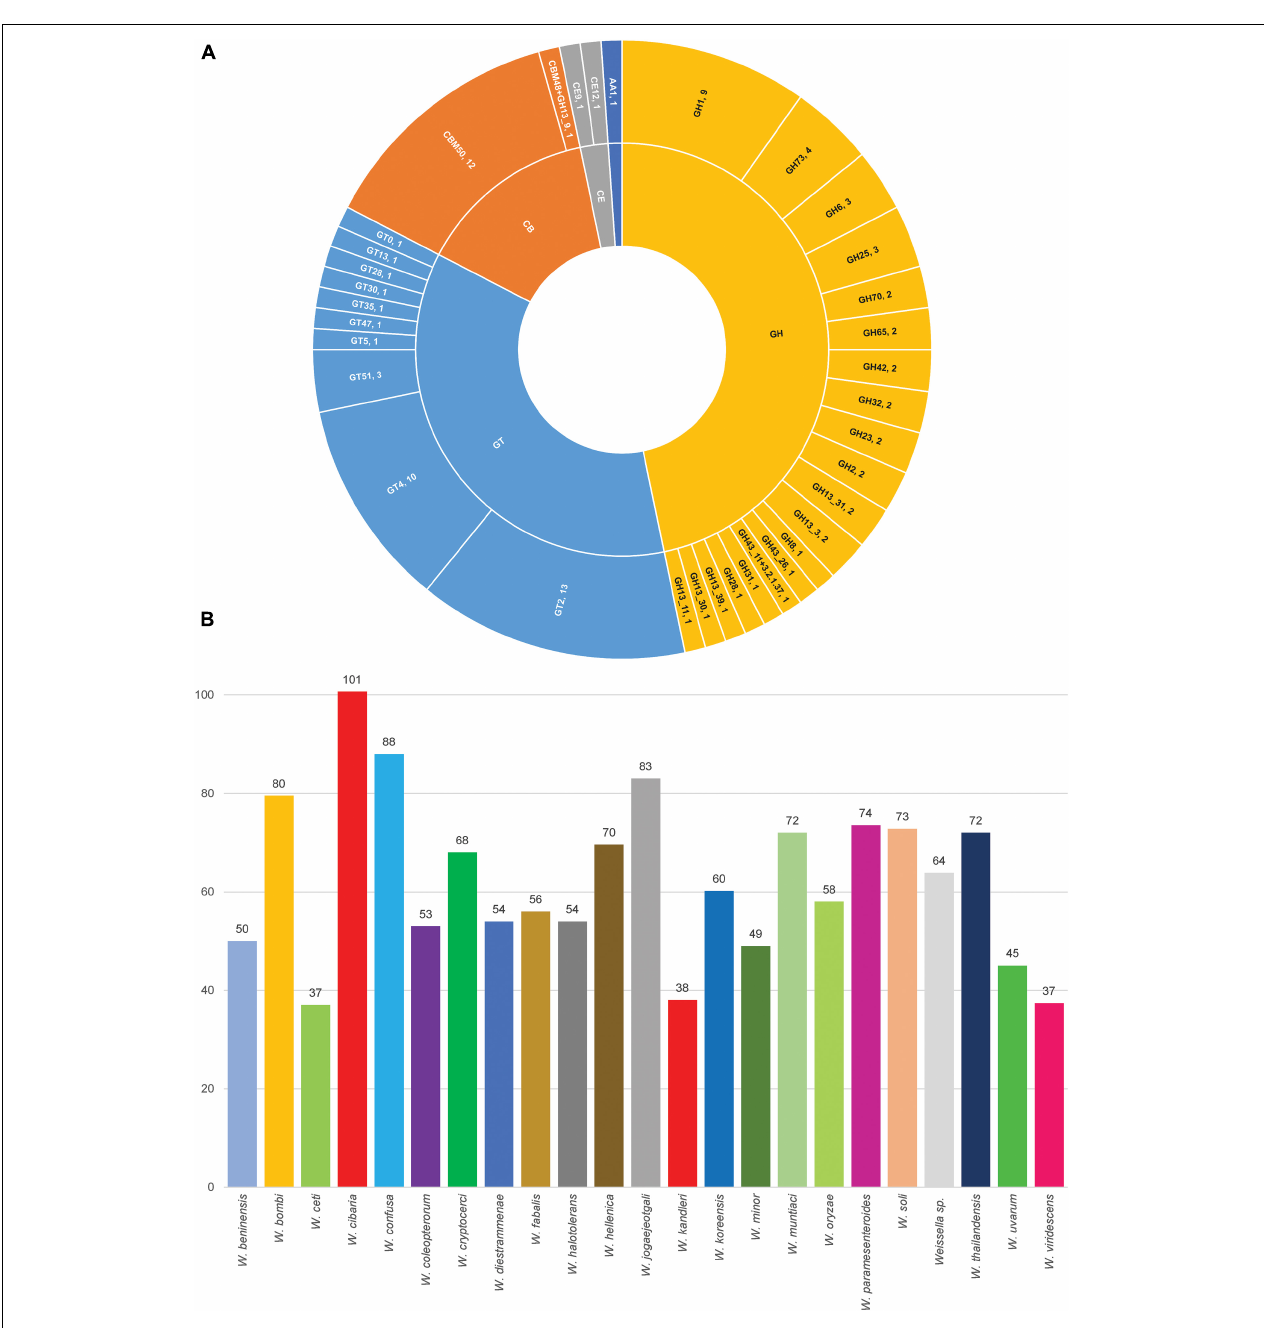
FIGURE 6 | Carbohydrate-active enzyme analysis. (A) CAZymes distribution in W. cibari a NH9449. (B) Average count of CAZymes distribution in Weissella spp.